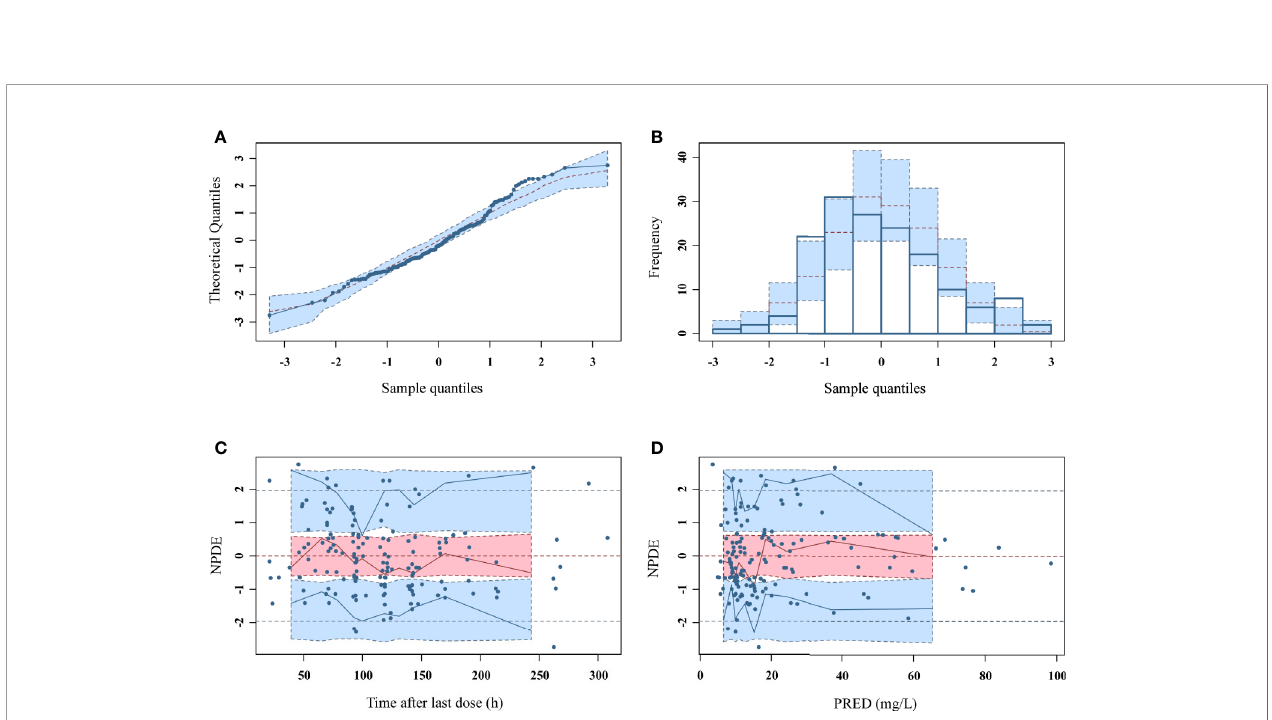
FIGURE 5 | NPDEs of the fi nal population pharmacokinetic model. (A) Quantile-quantile plot against the expected standard normal distribution; (B) Histogram of NPDE with the density of the standard normal distribution overlaid; (C) Scatterplot of NPDE against time; (D) Scatterplot of NPDE against